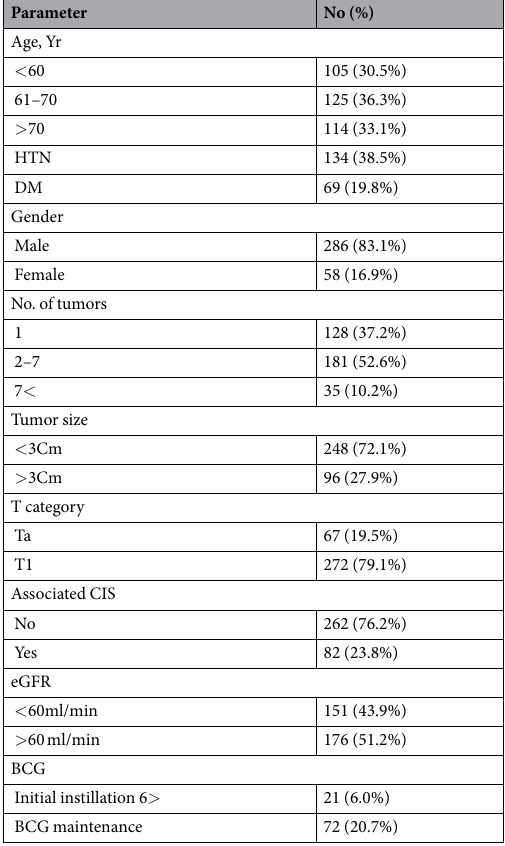
Table 1. Clinical and pathological characteristics of